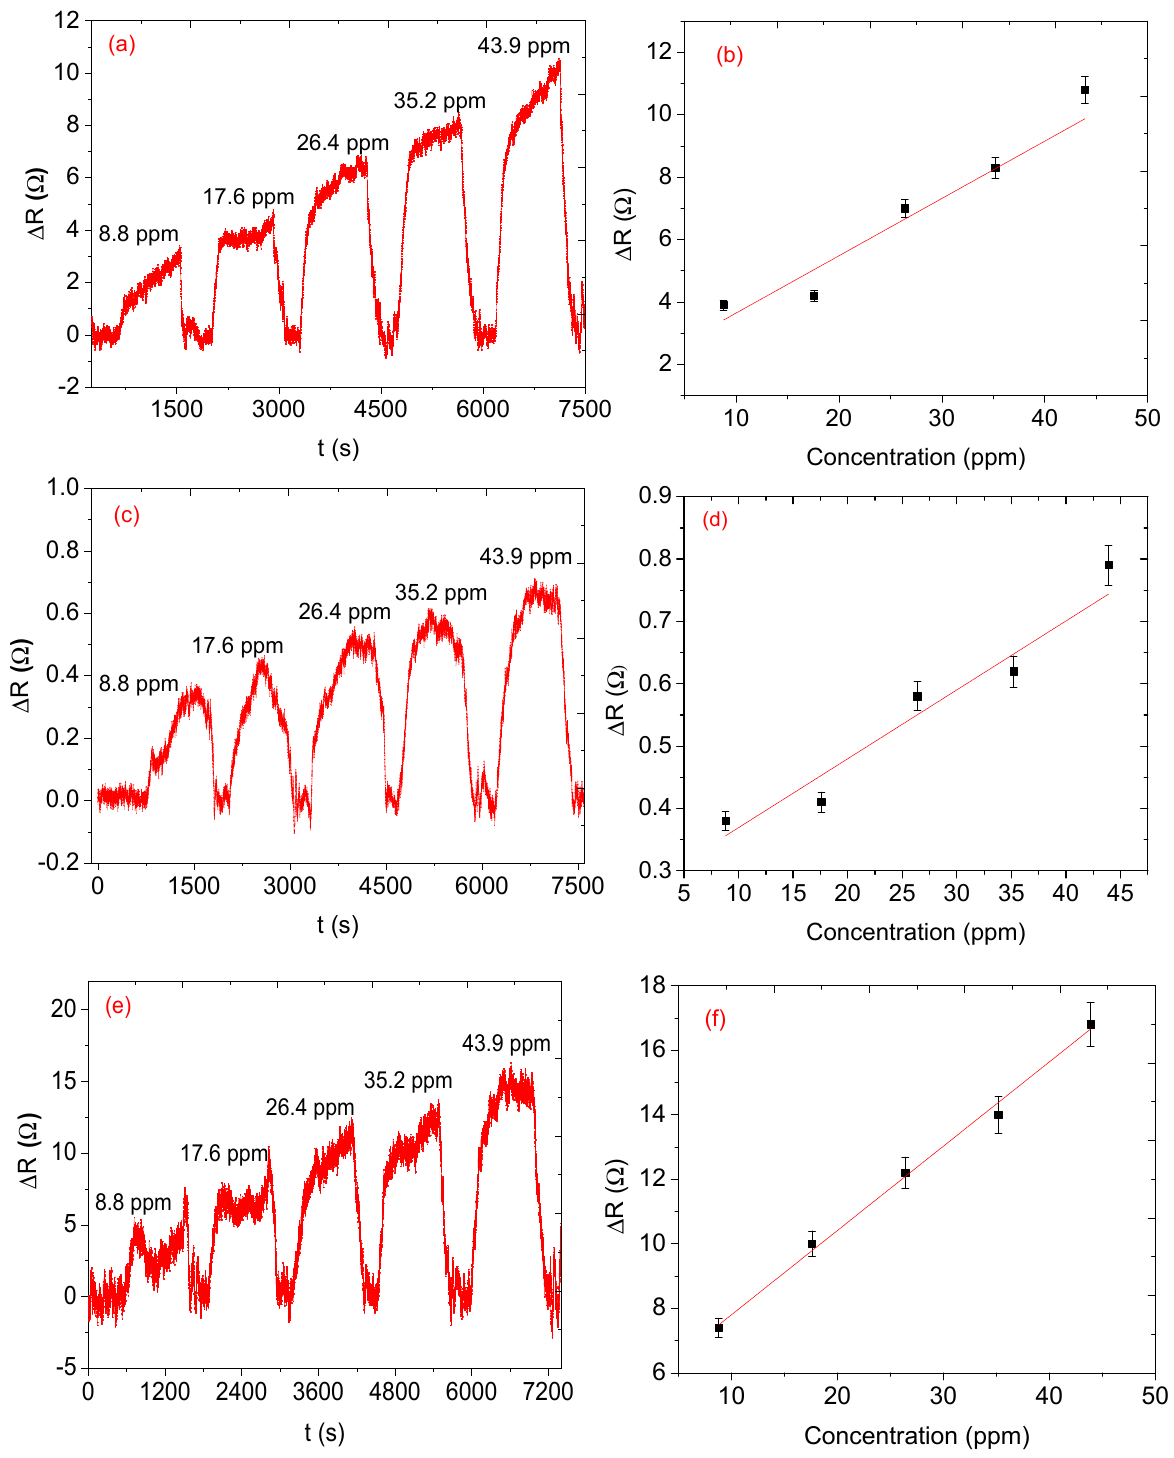
Figure 11. Dynamic response-recovery curve ∆ R response as a function of time at variable concentra- tions of NiO-CNPS-CA sensor with a mass ratio of ( a ) and ( b ) 1:1:3 (Snr 7), ( c ) and ( d ) 3:1:3 (Snr 8) and ( e ) and ( f ) 6:1:3 (Snr 9).